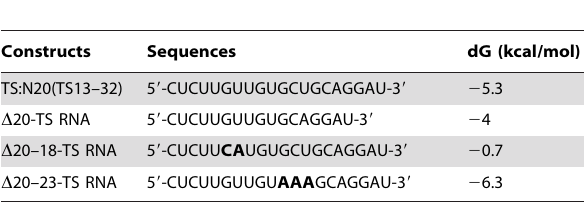
Table 2. Stability of TS:N20 and its mutant constructs.